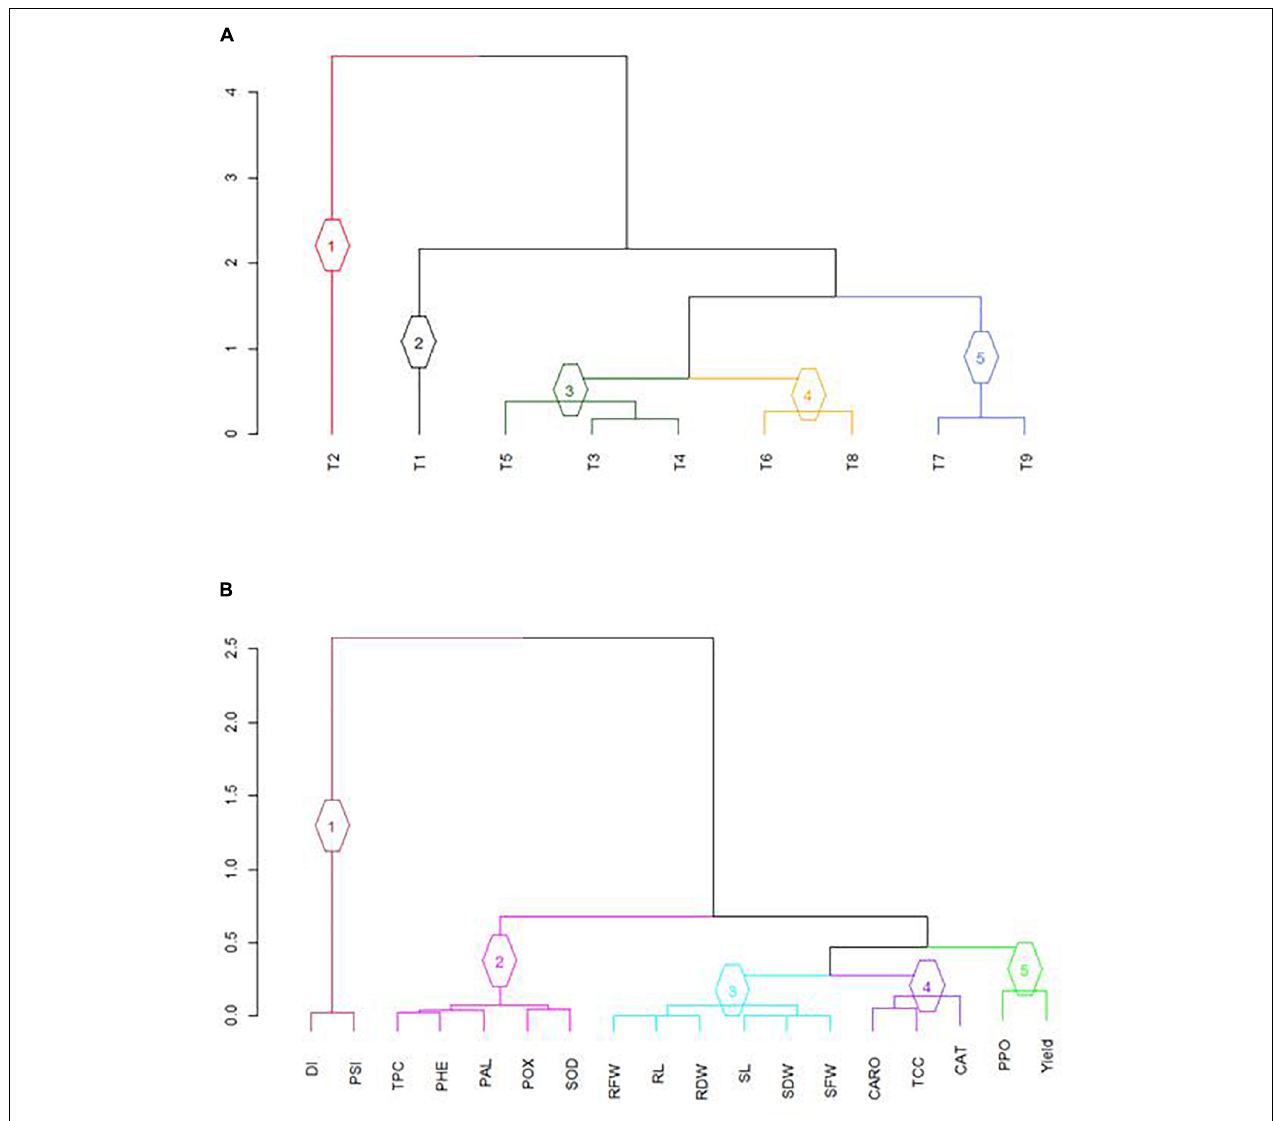
FIGURE 5 | Optimized dendrogram computed from average squared Euclidean distance matrix using UPGMA clustering method: (A) classification based on nine treatments; and (B) classification based on disease, growth, physio-chemical, and yield attributes. Different groups are presented with different colors for easy group identification. T 1 , − ve control (without inoculation of AS); T 2 , +ve control (with AS inoculation); T 3 , BS-01 + AS; T 4 , Zn (2X) + AS; T 5 , BS-01 + Zn (2X) + AS; T 6 , NPK + AS; T 7 , BS-01 + NPK + AS; T 8 , Zn (2X) + NPK; and T 9 , BS-01 + Zn (2X) + NPK + AS. BS-01, Bacillus subtilis ; AS, Alternaria solani ; NPK, nitrogen, phosphorus, and potassium; Zn,